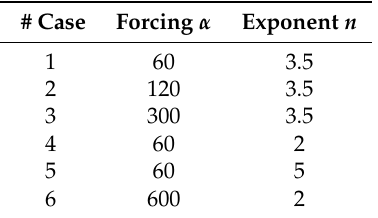
Table 1. Wave Generation Case